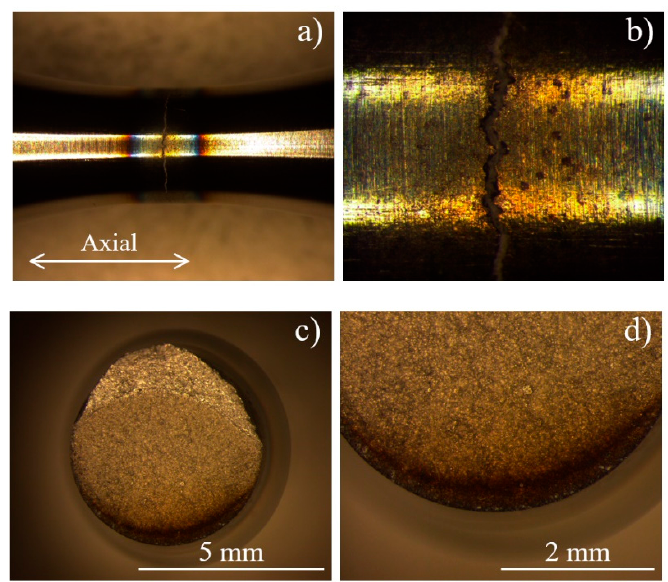
Figure 10. OM fracture images of annealed Inconel 718 ( R = − 1, f = 20 kHz, σ a = 400 MPa, Nf < 2 × 10 4 cycles): ( a , b ) specimen surface; ( c , d ) fatigue fracture.